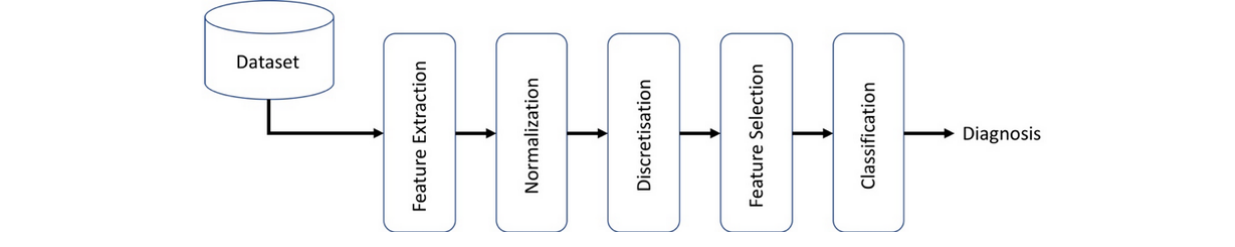
Figure 1. Experiment